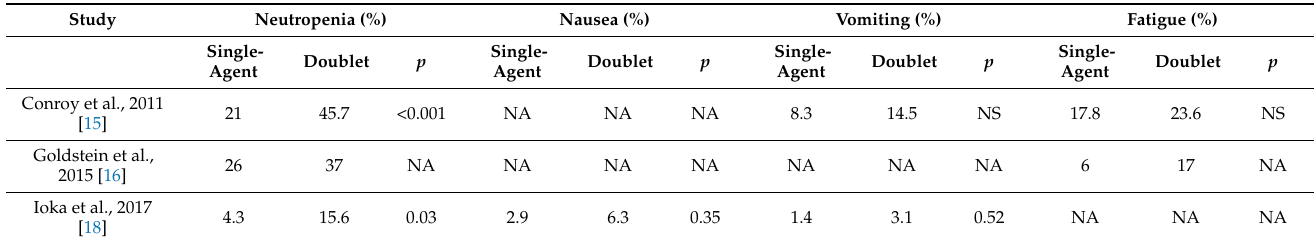
Table 5. Grade three and four adverse events for neutropenia, nausea, vomiting, and fatigue in each of the included